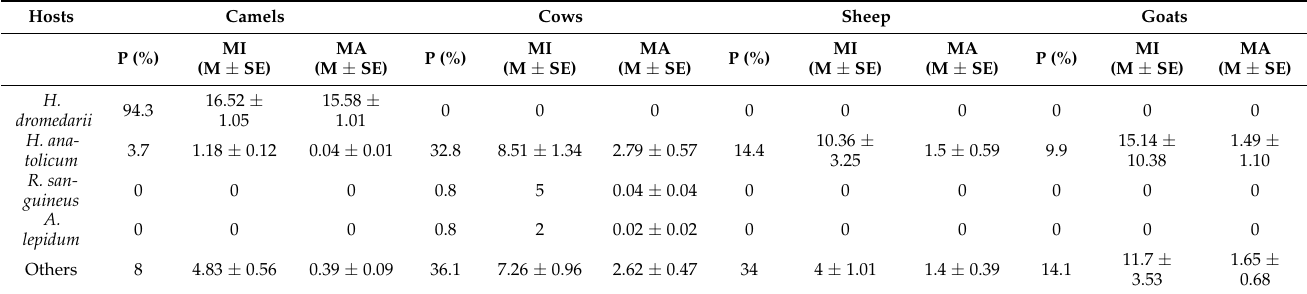
Table 4. Number (n) of tick species collected from camels, cows, sheep, and goats in the sampling areas, UAE. Hosts Camels Cows Sheep